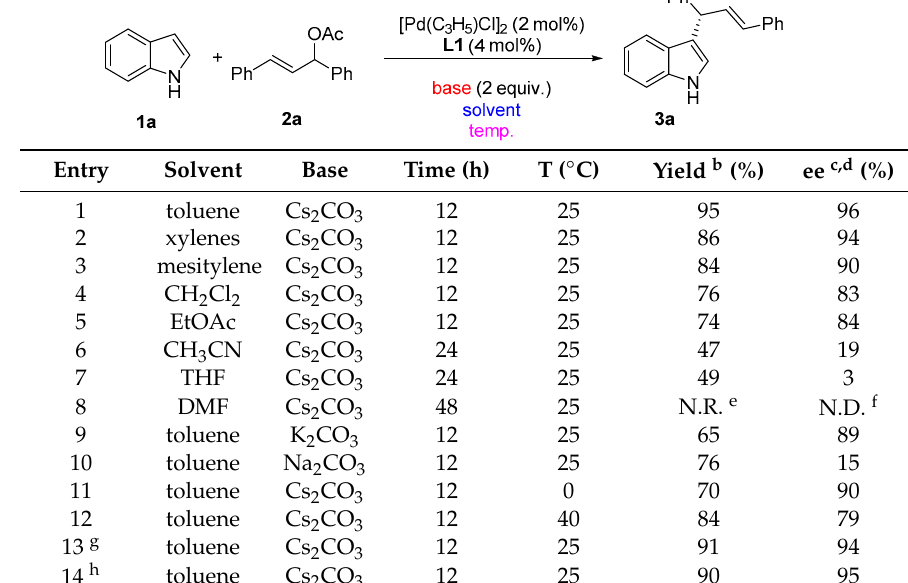
Table 2. Optimization of reaction conditions for Pd-catalyzed allylic alkylation of indoles. a